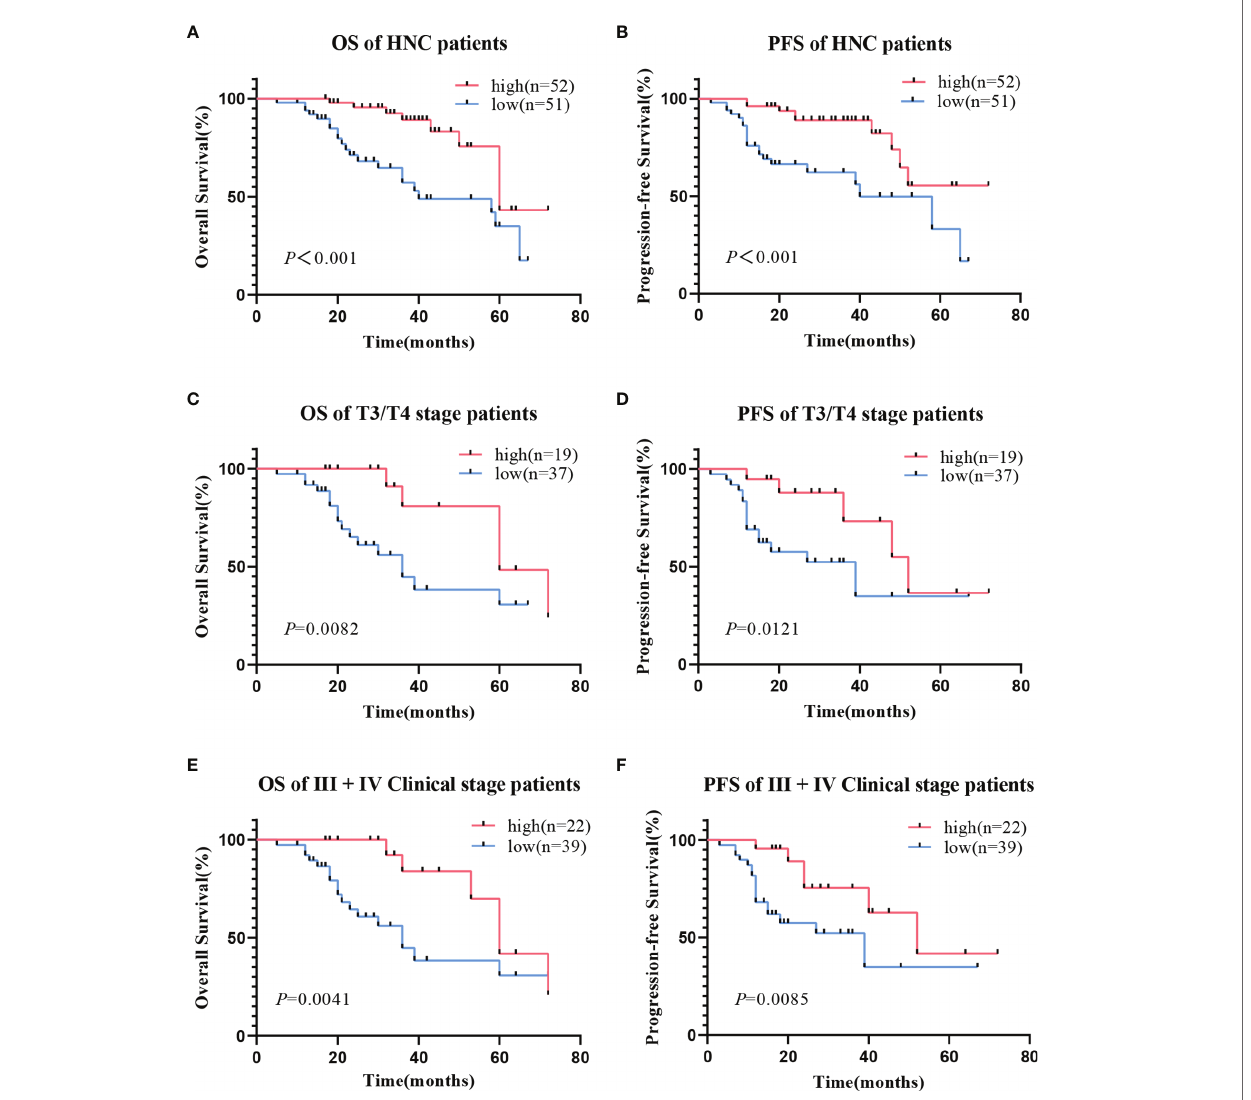
FIGURE 3 | Relationship between hsa_circ_0001675 expression and OS rate and PFS rate of HNC patients. (A) Low hsa_circ_0001675 expression was related to poor OS. (B) Low hsa_circ_0001675 expression was related to poor PFS. (C, D) Low hsa_circ_0001675 expression was signi fi cantly correlated with poor OS and poor PFS in advanced T stage (T3/T4) patients. (E, F) Low hsa_circ_0001675 expression was signi fi cantly correlated with poor OS and PFS in advanced clinic stage patients (III,